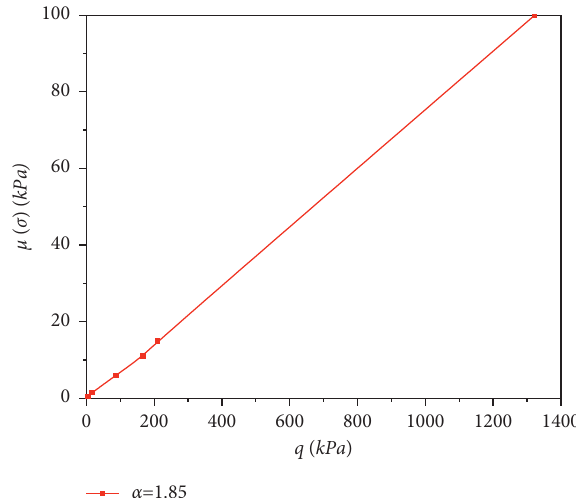
Figure 17: Relationship curve between membership degree and shear